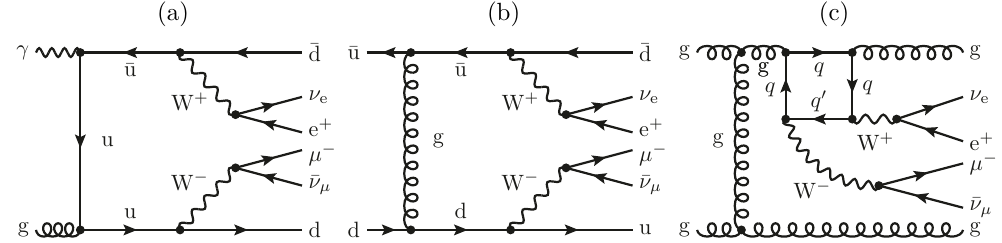
(cid:0) (cid:1) g s g 5 , a gluon-photon-induced contribution (a), O (cid:0) (cid:1) g 4 g 4 , a loop-induced contribution s O